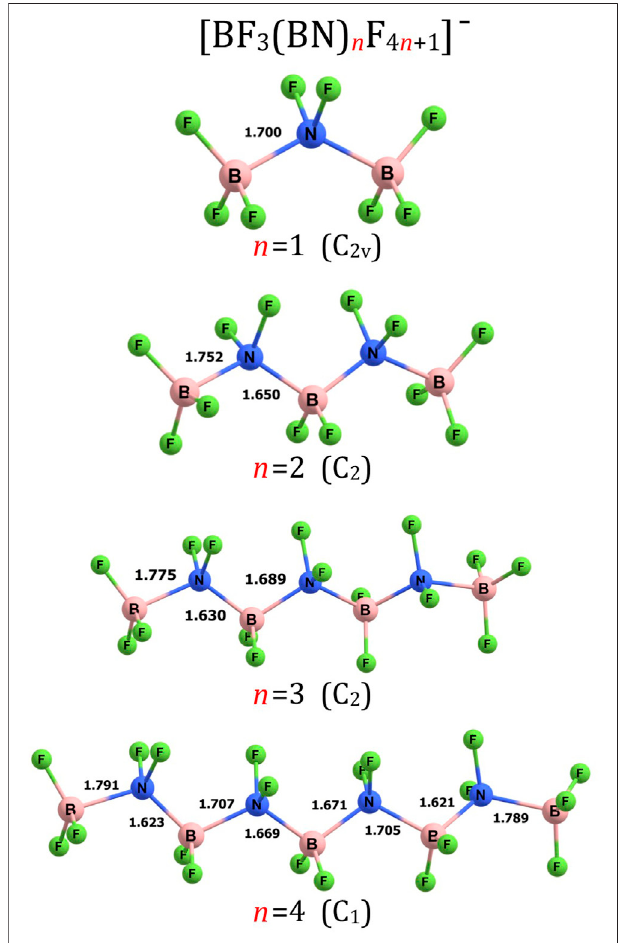
FIGURE 1 | Equilibrium structures of (BF 3 (BN) n F 4 n +1 ) – ( n = 1 – 4) anions (symmetry point group in parenthesis). Selected bond lengths are given in